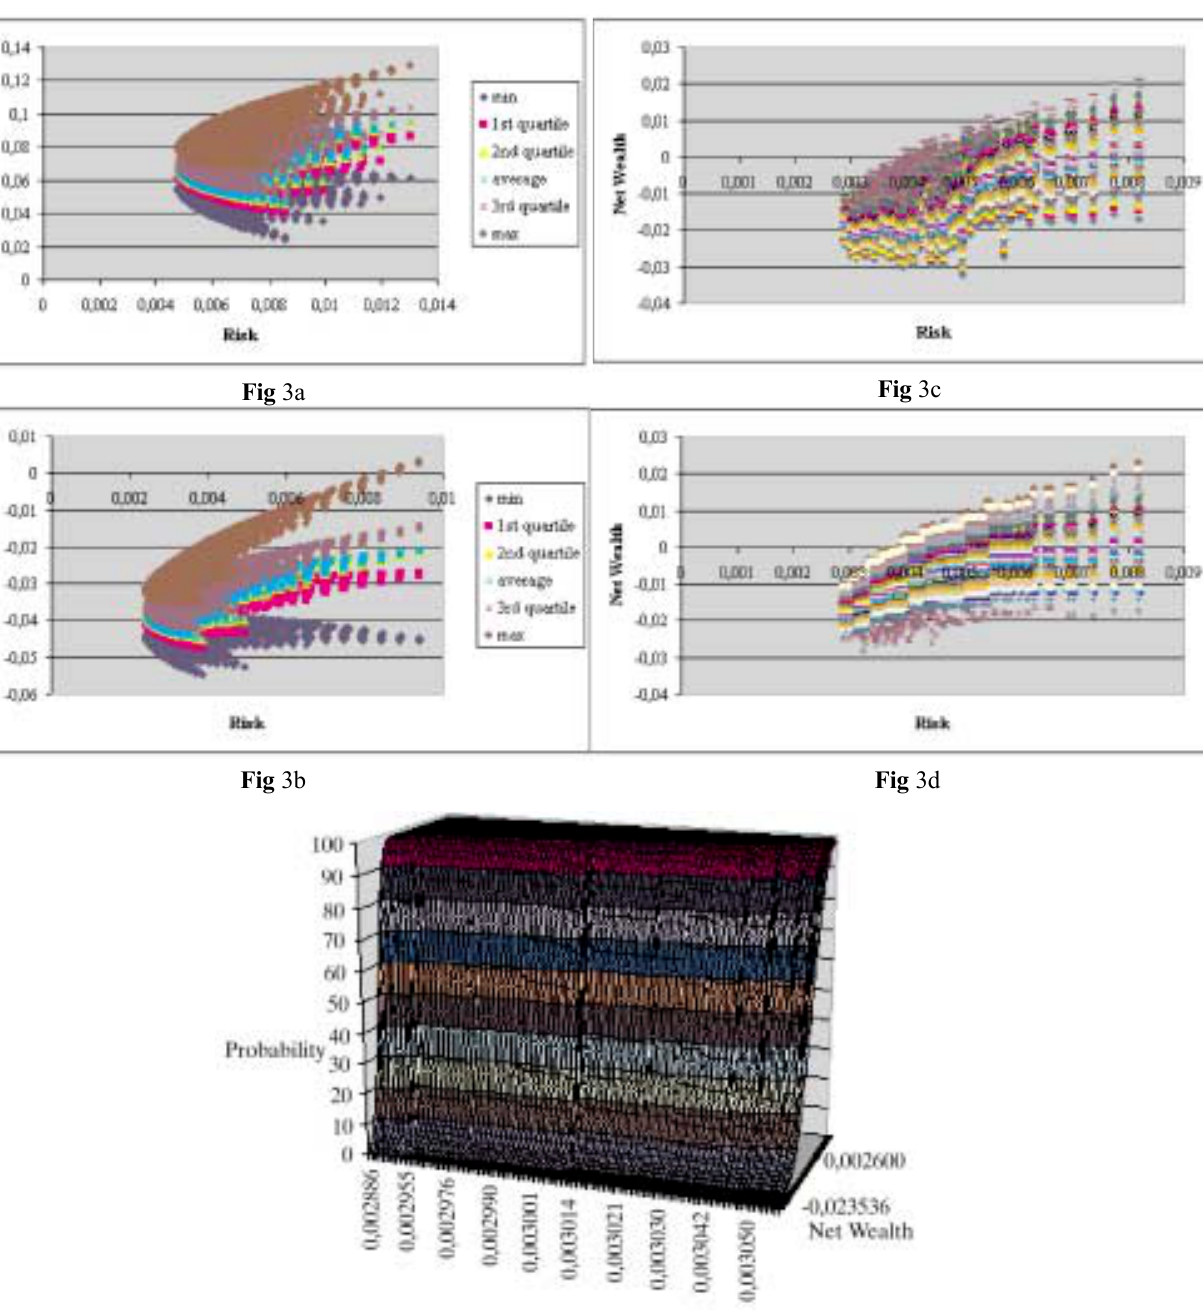
Fig 3. Possibility sets of asset and liability portfolio analogues: 3a (cid:150) assets portfolio analogues of standard deviation 0,005; 0,25; 0,5; 0,75 and 0,995 levels of quintiles; 3b (cid:150) liabilities portfolio analogues of standard deviation 0,005; 0,25; 0,5; 0,75 and 0,995 levels of quintiles; 3c (cid:150) assets and liabilities portfolio analogues of standard deviation 0,005; 0,25; 0,5; 0,75 and 0,995 levels of quintiles; 3d (cid:150) isoguarantees of corresponding level of assets and liabilities portfolio analogue; 3e (cid:150) survival functions family of portfolio